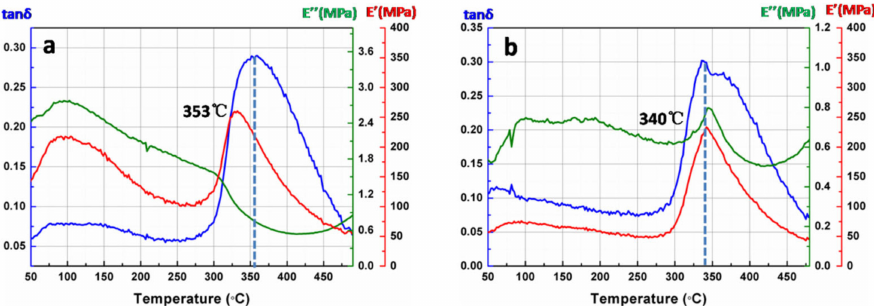
Figure 10. The DMA results of PI membranes ( a ) before and ( b ) after coated with SiO 2 antireflective membrane in nitrogen. Table 3. Thermal properties of membranes before and after coated with SiO 2 antireflective membrane.